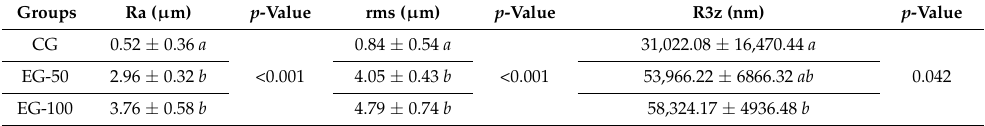
Table 2. Descriptive statistics (mean and standard deviation) of the surface roughness analysis.